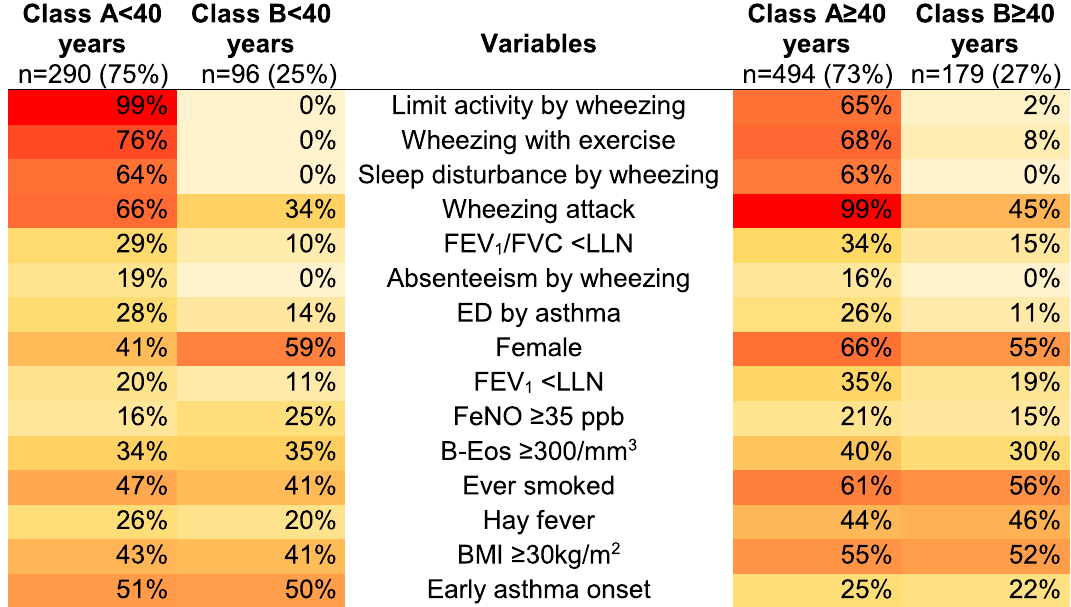
Table 1 Proportions of each variable according to the LCA-classes identified in Model 2 (subjects with current asthma, n =